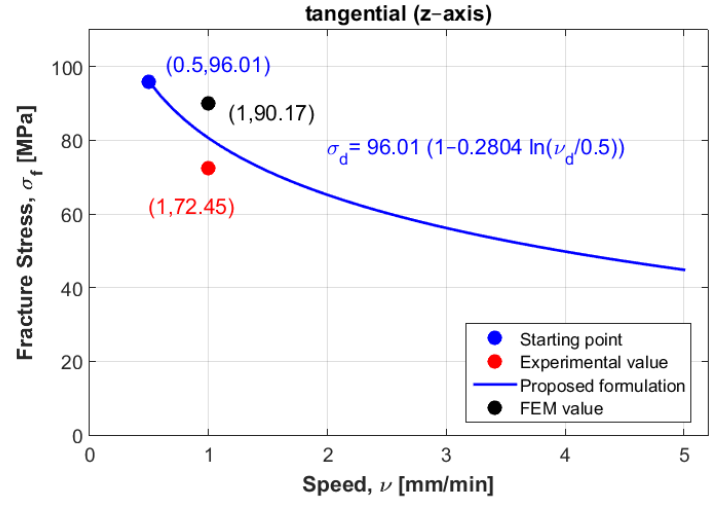
Figure 12. Curve modeling for the tangential direction and the experimental point at the second displacement rate.